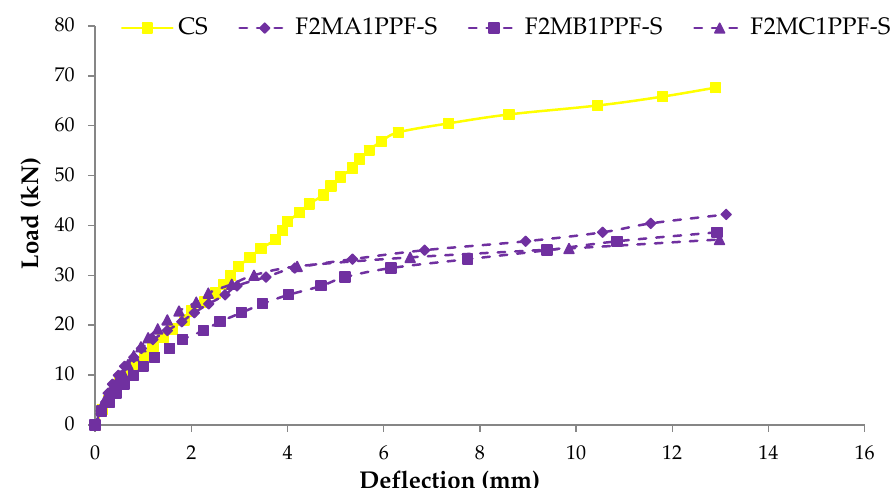
Figure 15. Comparison of load-deflection for different % of PPF and two steel wire mesh.